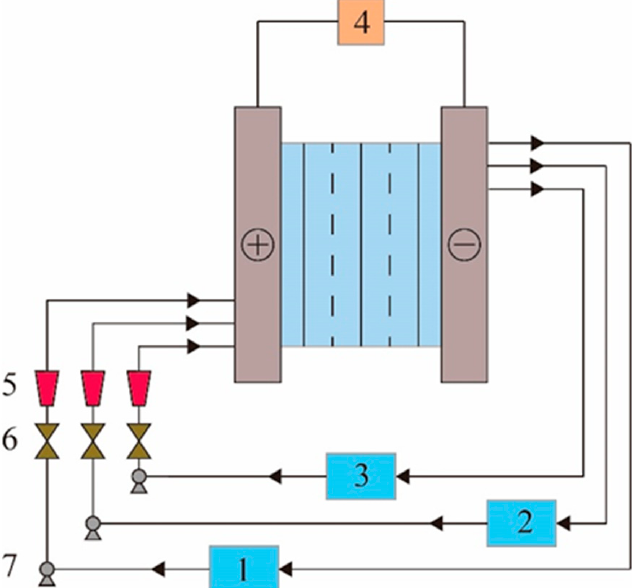
Figure 2. Schematic diagram of Pilot-Scale electrodialysis device. 1—Concentration compartment circulation tank; 2—Dilute compartment circulating tank; 3—Electrode liquid circulation tank; 4— DC stabilized power supply; 5—Flowmeter; 6—valve; 7—circulating pump.